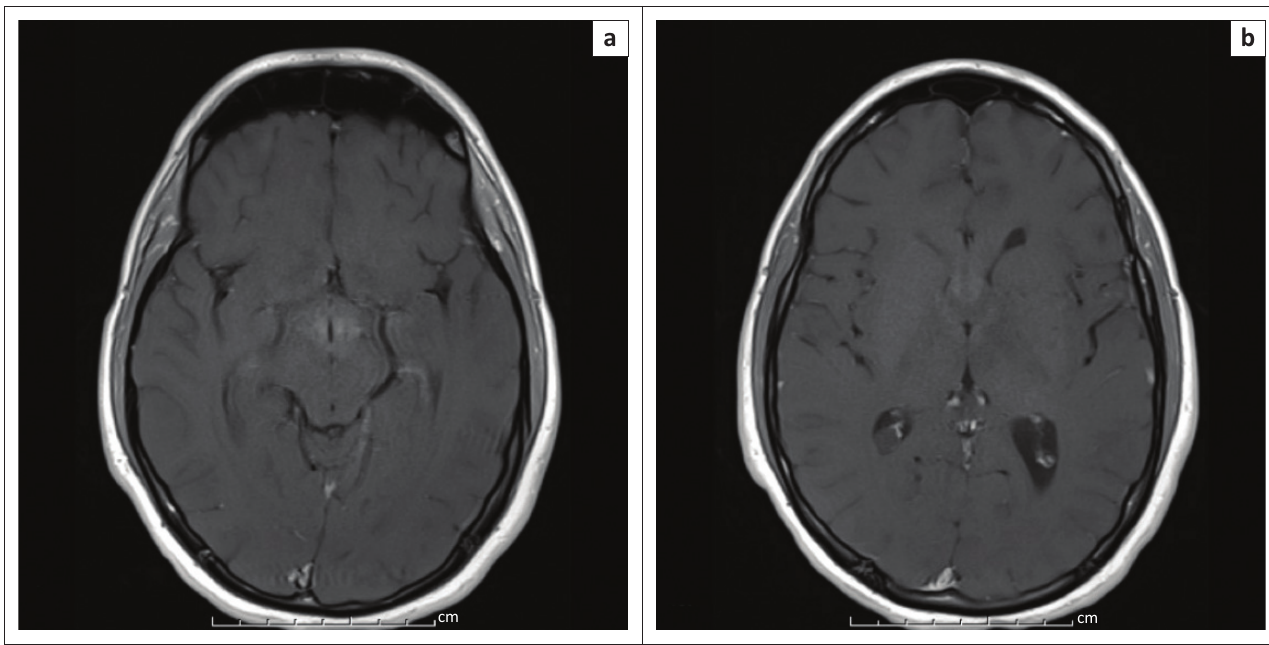
FIGURE 4: T1-weighted post-contrast imaging (a and b) following surgery demonstrates near-complete resolution of the previously noted enhancement.